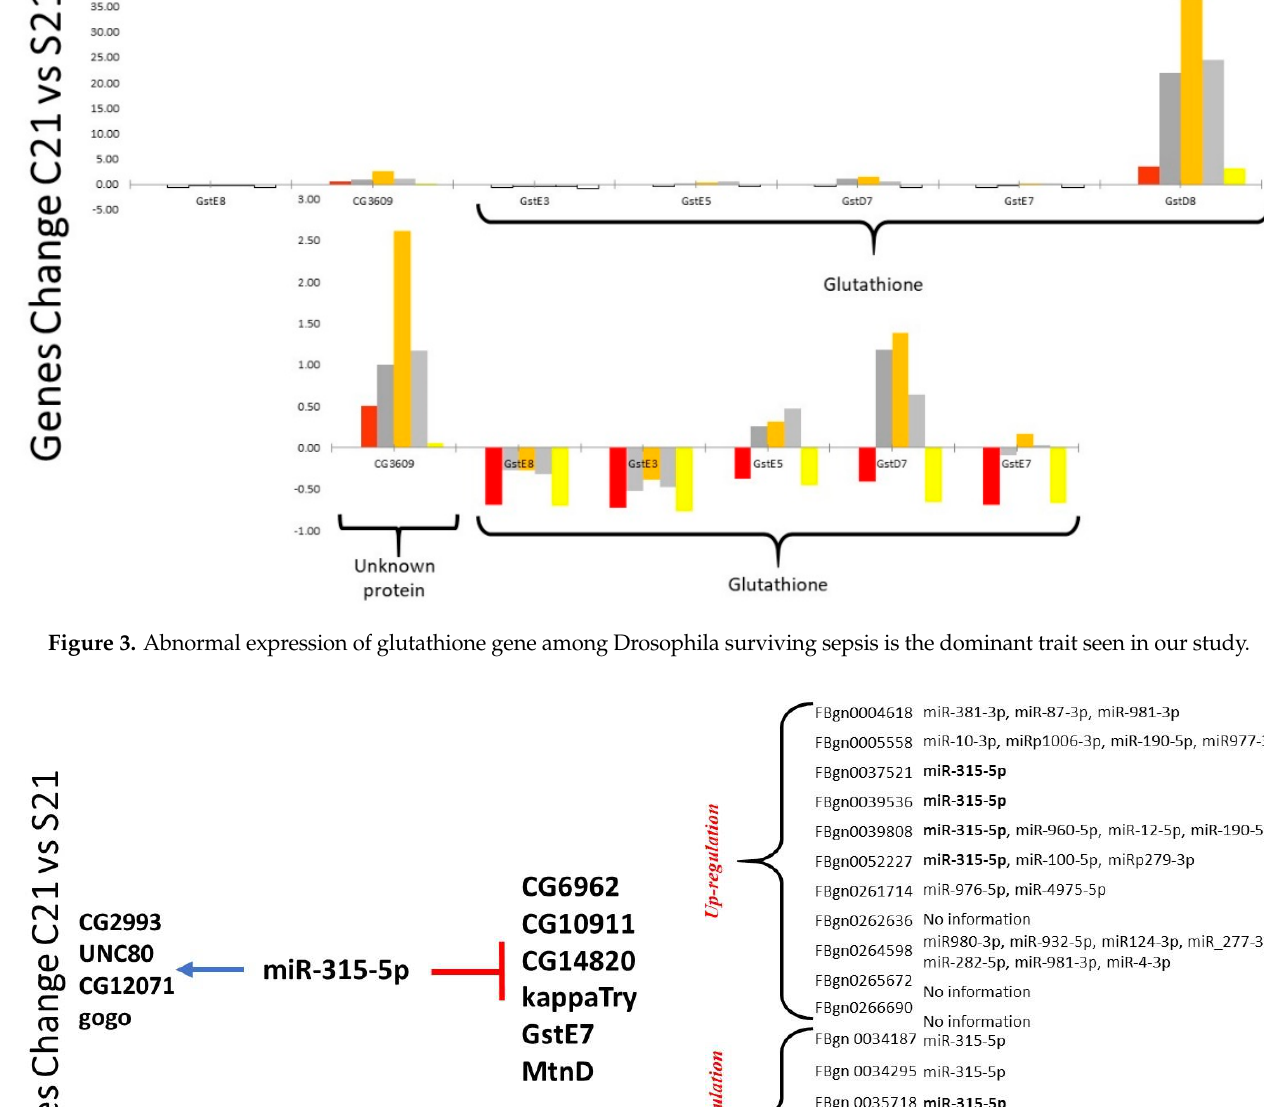
Figure 3. Abnormal expression of glutathione gene among Drosophila surviving sepsis is the dominant trait seen in our study.